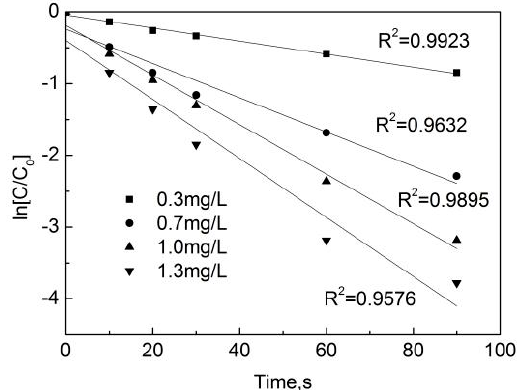
Figure 3. Dynamic fitting curves of OFL under different free chlorine concentrations in deionized water.